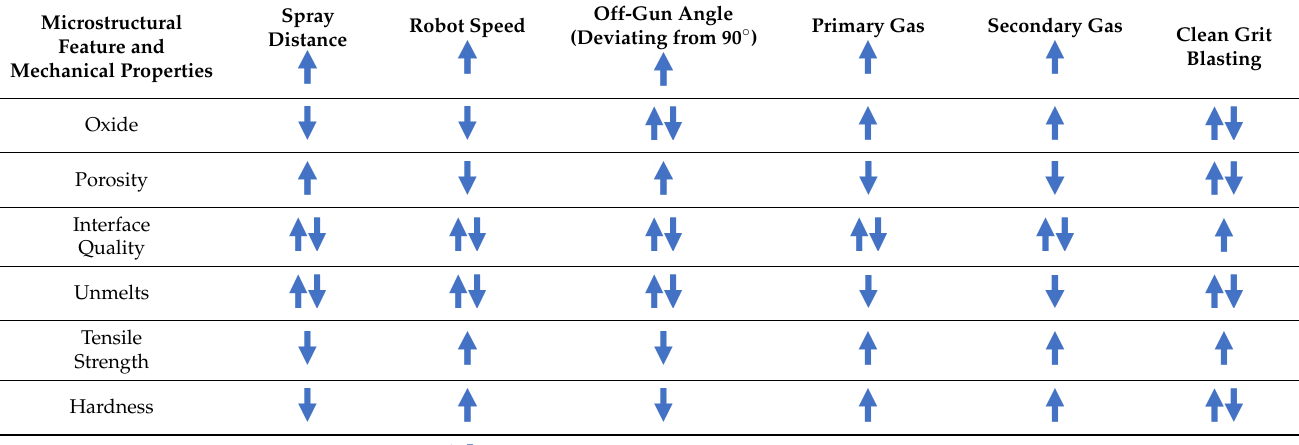
Table 3. Effects of parameters on the microstructure and mechanical properties of a